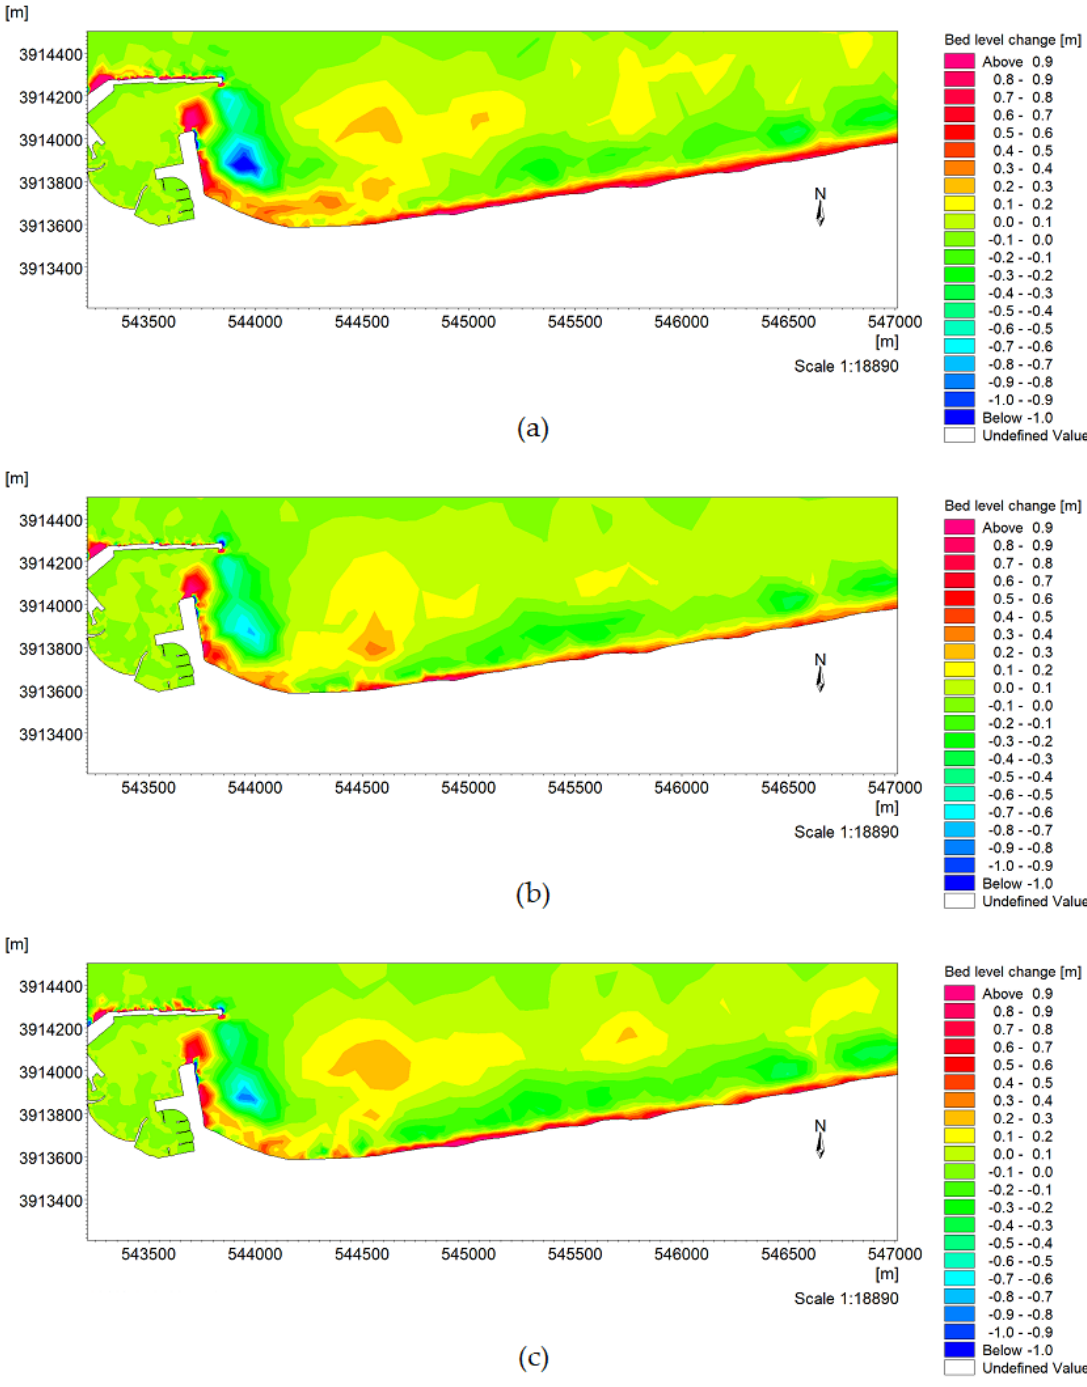
Figure 9. Bed-level changes obtained by the reference simulation ( a ) and implementation of the pick-up rate method ( b ) and energy-flux method ( c ) for the set covering a year of data.